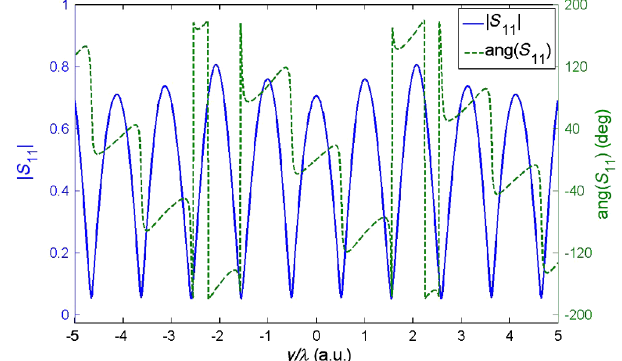
FIG. 5. S 11 (reflection coefficient) of an infinite array of GSP resonators as a function of their lengths. FIG. 6. The transformed magnitudes (blue line) and phases (green line) of the S 11 parameters from the equivalent